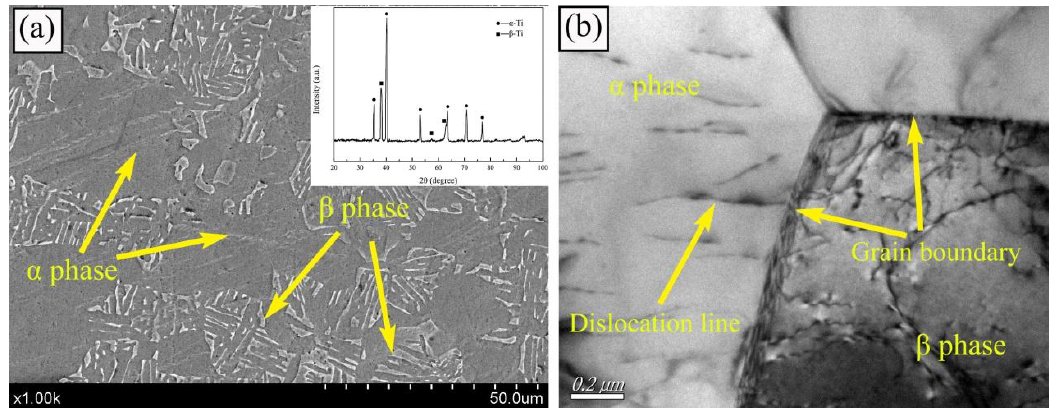
Figure 2. ( a ) The microstructure of the Ti-6Al-4V alloy before LSP and the inset showing the corresponding XRD pattern. ( b ) The bright field TEM image of the coarse-grained alloy.